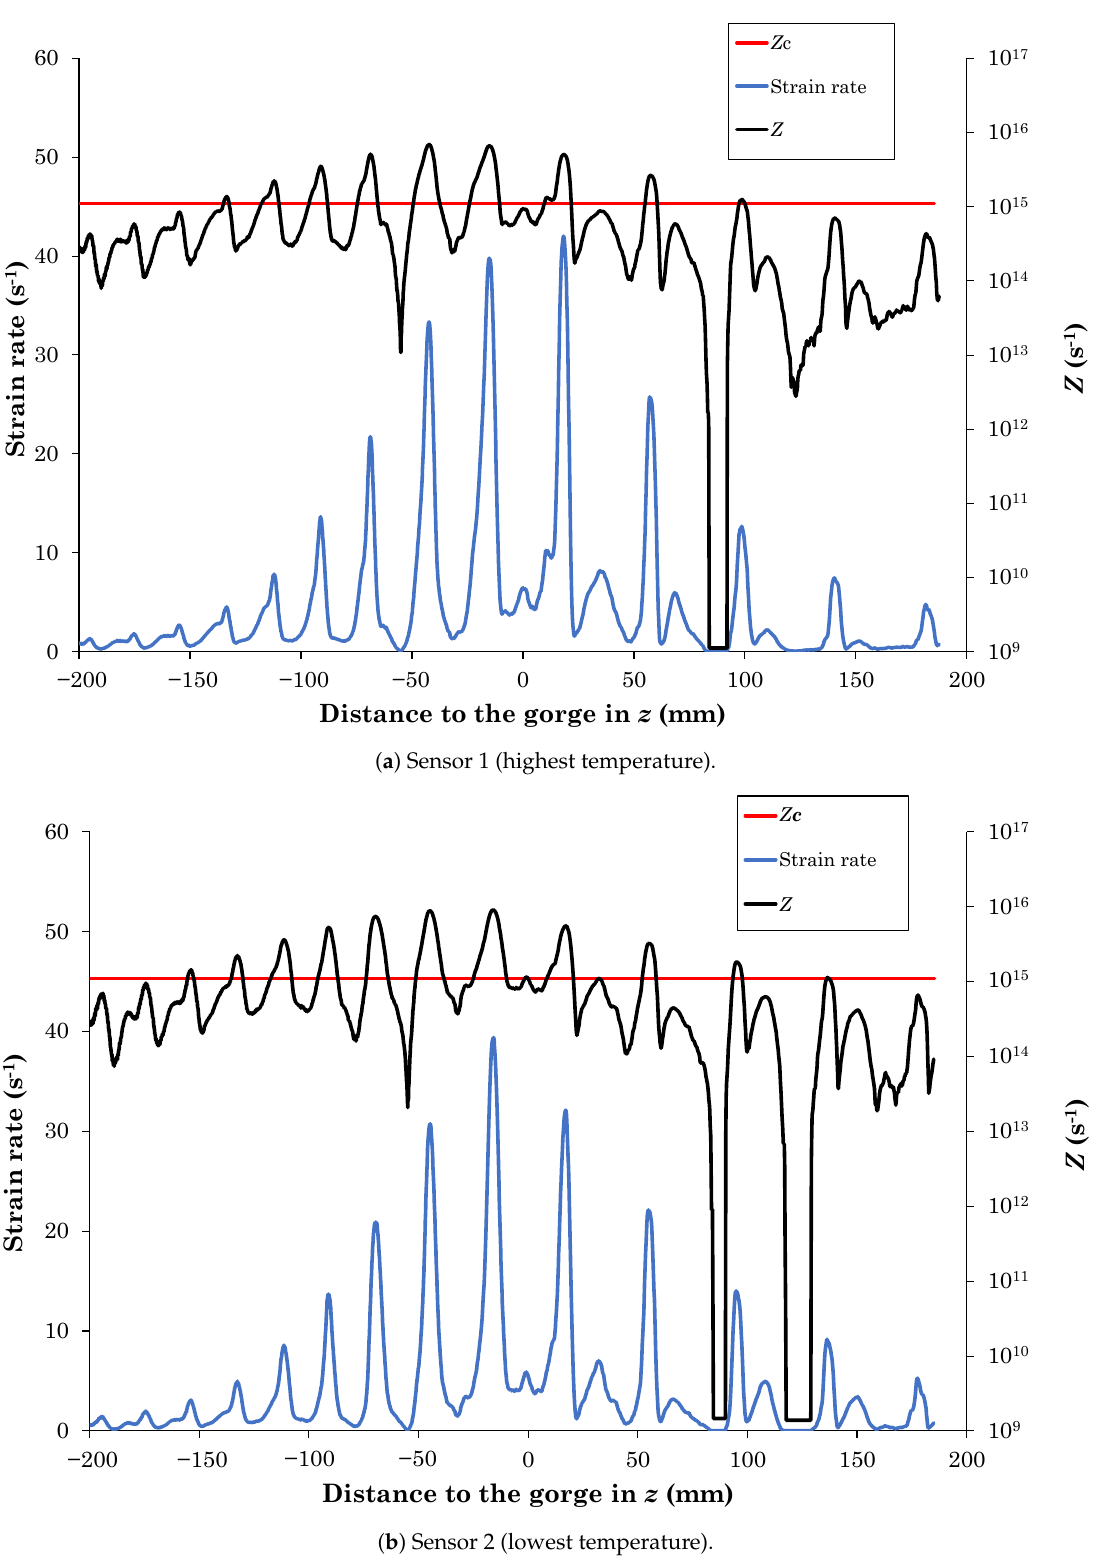
Figure 4. Evolution of the Zener–Hollomon parameter Z and the strain rate with respect to the distance to the